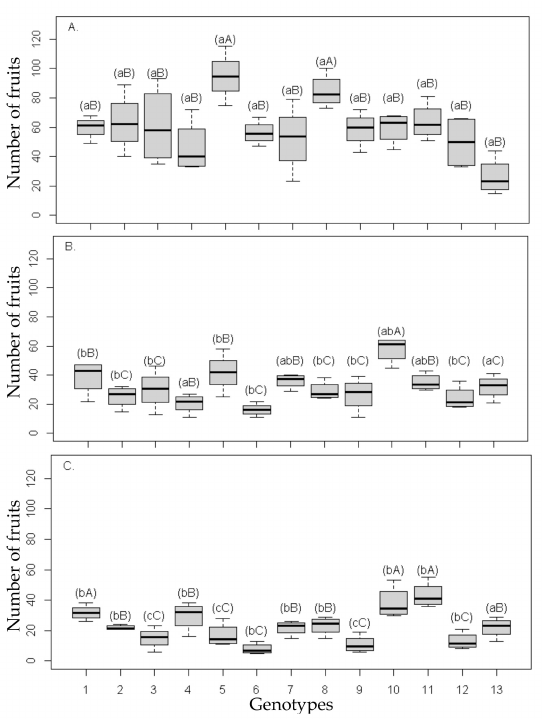
Figure 4. Boxplot relative to the average number of fruits per plant of 13 citrus rootstocks in combination with ‘Tahiti’ acid lime ( Citrus × latifolia (Yu. Tanaka) Tanaka) under irrigation with waters of 0.14 ( A ), 2.40 ( B ), and 4.80 dS m − 1 ( C ), in the secund year. For identification of genotypes, see Table 1. Boxplots with the same lowercase letter do not differ statistically, according to the Tukey test between salinity levels ( p ≤ 0.05), and those with the same uppercase letter belong to the same genotype group, according to the Scott–Knott test ( p ≤